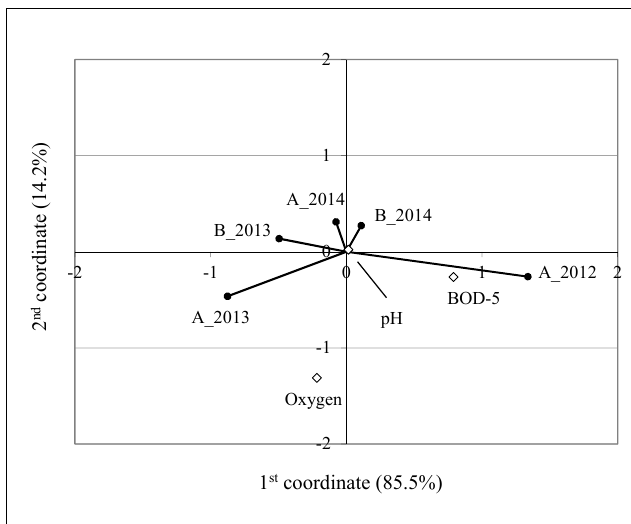
Figure 5. Position of experimental objects determined by pH reaction, oxygen concentration and biochemical oxygen demand in the space of the first two canonical variates and the spacing of these parameters in the dual space.